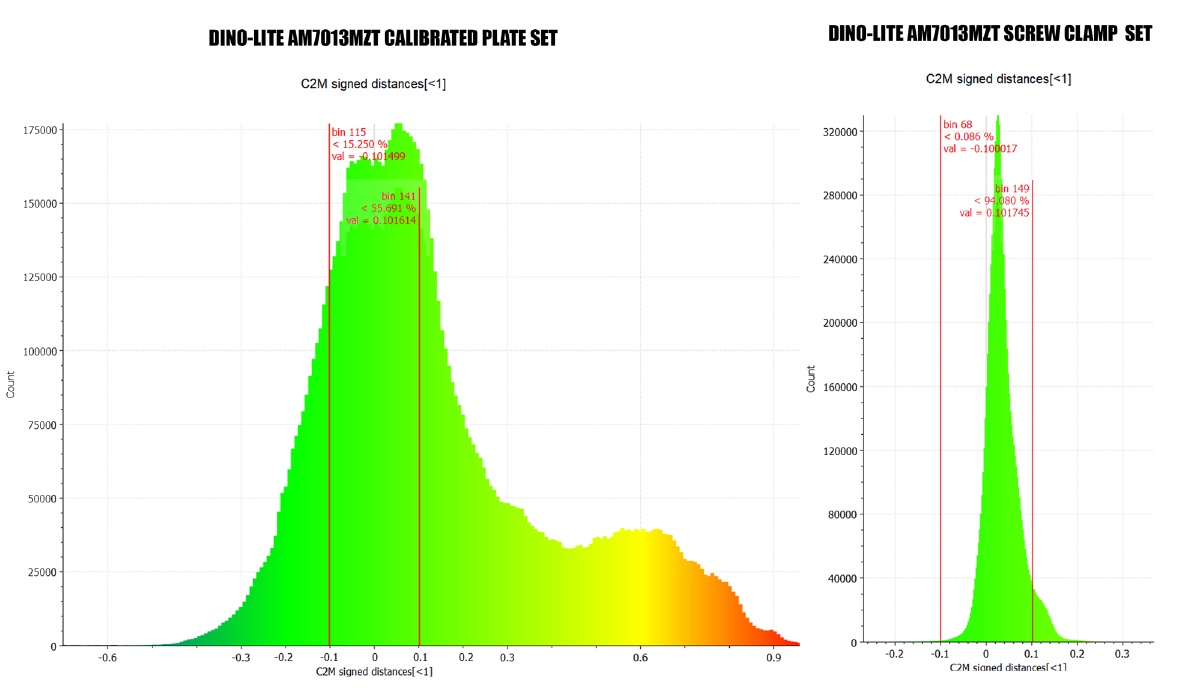
Figure 12 . Global distribution detailed chart of photogrammetric cloud deviations from the reference model: in the central portion of the graphic, approximately 40% (left) and 94% (right) of the points are included in a difference of +/-